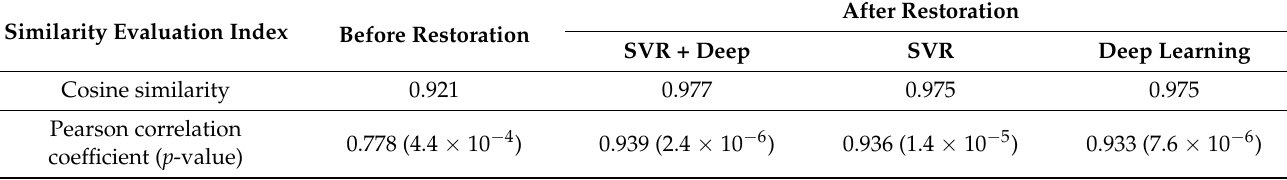
Table 1. Training results in terms of similarity before and after rPPG restoration by using two metrics such as cosine similarity and Pearson correlation coefficient with p -value.